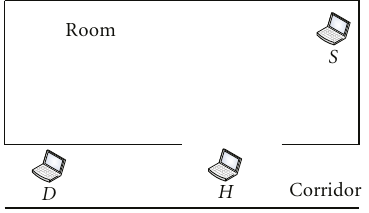
Figure 19: Scenario 2